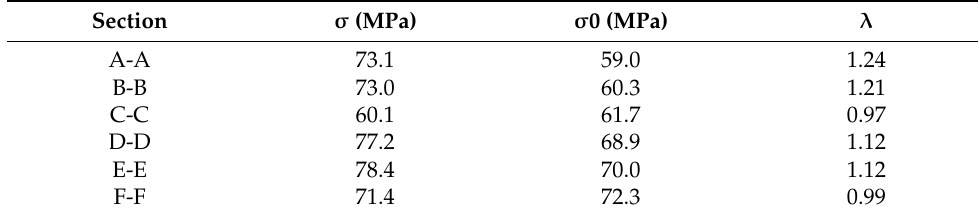
Table 9. Calculation of shear lag coefficient.